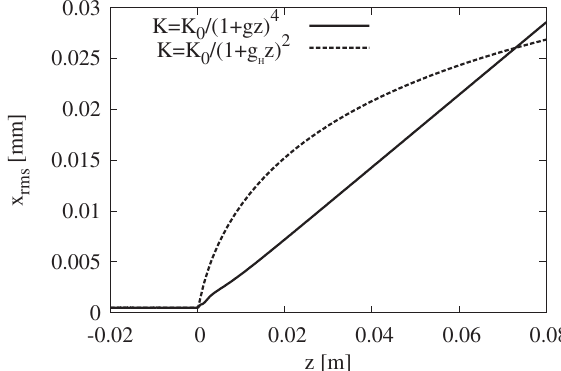
FIG. 5. Development of the beam size for different field profiles.